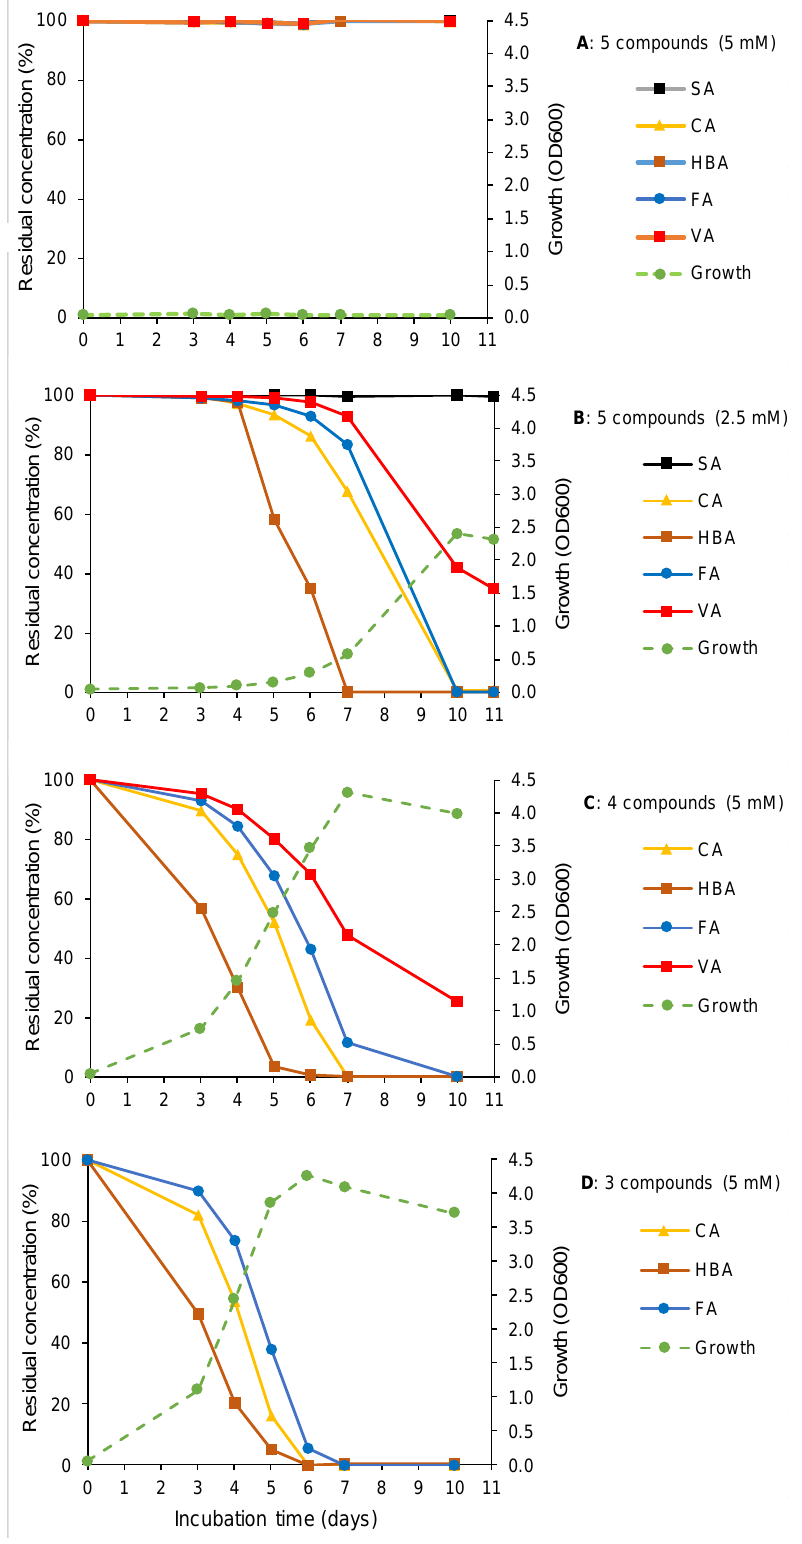
Figure 3. Biodegradation performance and growth of R. colostri DBVPG 10655 at 10 ◦ C in the presence of five (( A ) 100% = 5 mM; ( B ) 100% = 2.5 mM), four (( C ) 100% = 5 mM), and three (( D ) 100% = 5 mM)) lignin-derived aromatic monomers (SA, syringic acid; CA, p -coumaric acid; HBA, 4-hydroxybenzoic acid; FA, trans -ferulic acid; VA, vanillic acid) as sole carbon sources (mean values of three replicates; SDs ≤